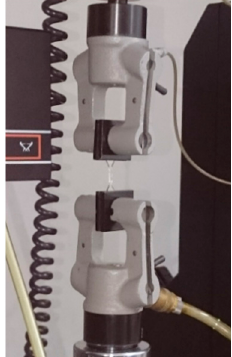
Figure 3. Specimen clamping during tensile test by Universal Instron Testing Machine 5500R.